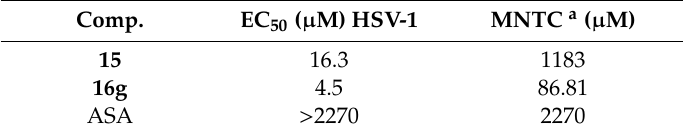
15 , Figure 7), Figure 7), and